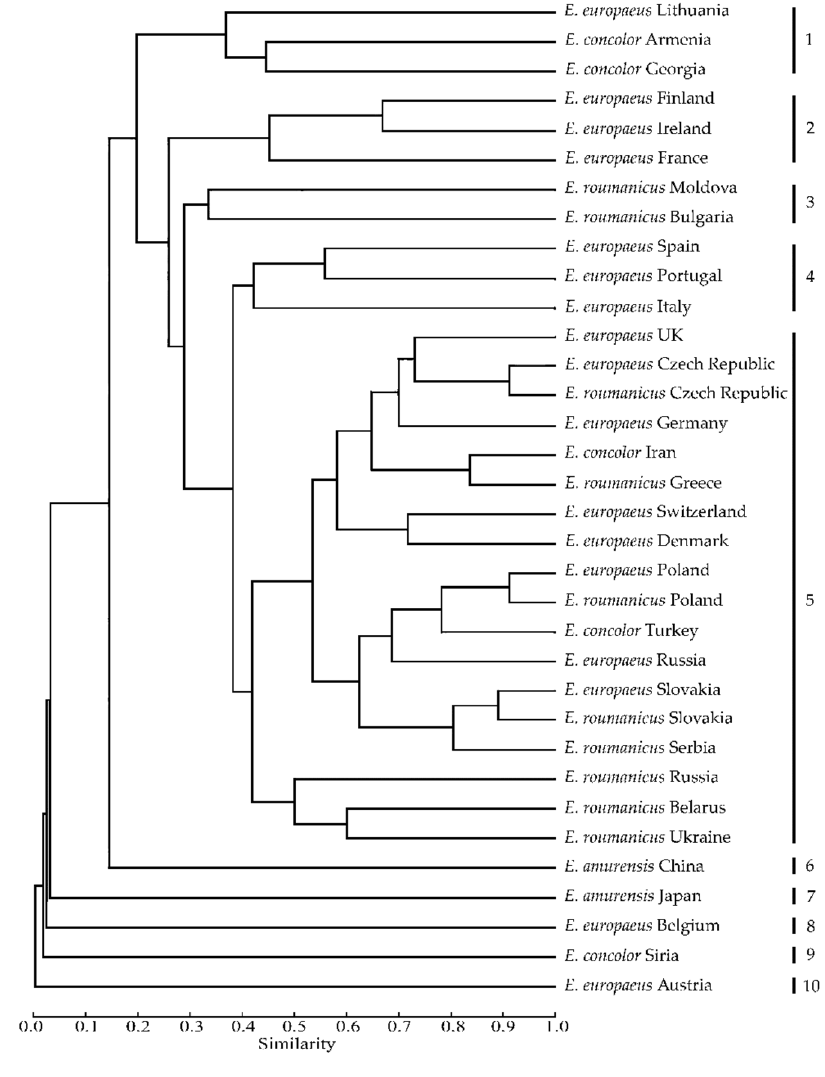
Figure 2. Similarity dendrogram of the helminth faunas in Erinaceus spp. from various countries, obtained by the Morisita index (UPGMA). Cophen. corr.: r = 0.875.